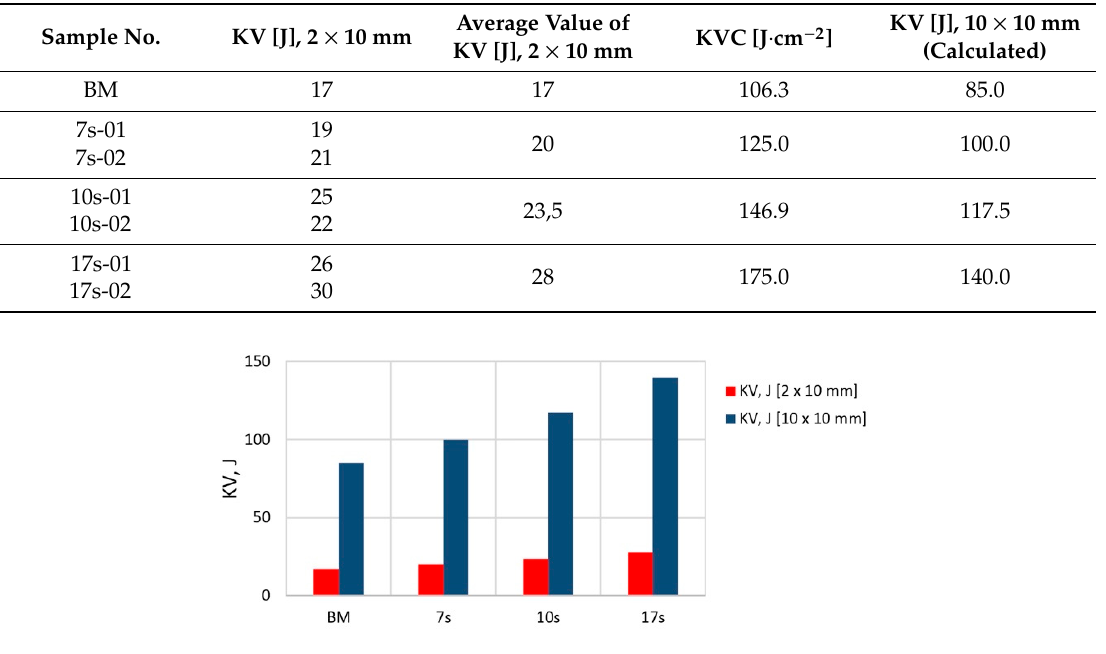
Figure 12. Absorbed energy KV for the base material and samples with different cooling times t 8/5 .